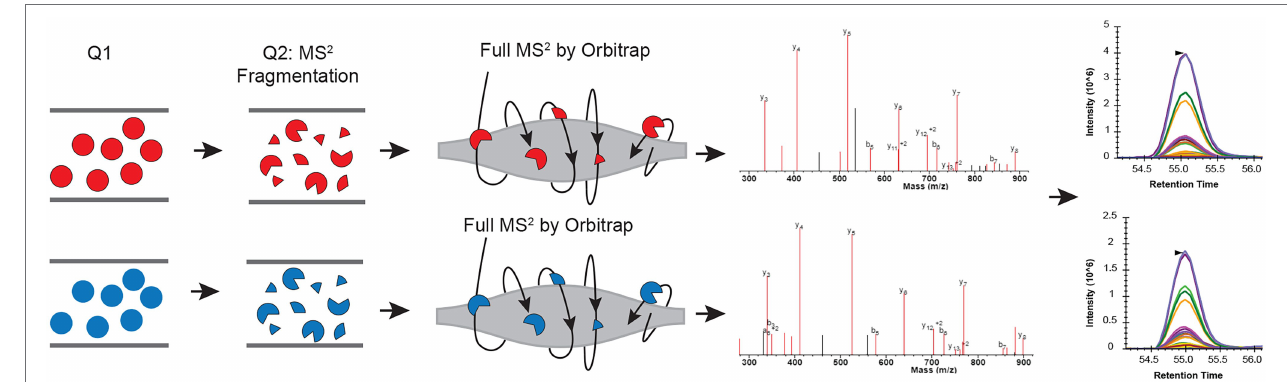
FIGURE 1 | Schematic view of combining parallel reaction monitoring to 15 N metabolic labeling quantification workflow to get unambiguous quantification results. In each parallel reaction monitoring (PRM) cycle, light ( 14 N; colored in red) and heavy ( 15 N) labeled peptide (colored in blue) ions from the target list are sequentially isolated in the first quadrupole (Q1). These ions are then fragmented using, for example, higher-energy collision dissociation (HCD), in the second quadrupole (Q2). The resulting MS 2 fragments are separated and detected by the Orbitrap. The MS 2 fragments from the light and heavy pairs are measured/scanned multiple times (cycles) across their elution profile. The area under the curve (AUC) of the fragment ions are integrated for